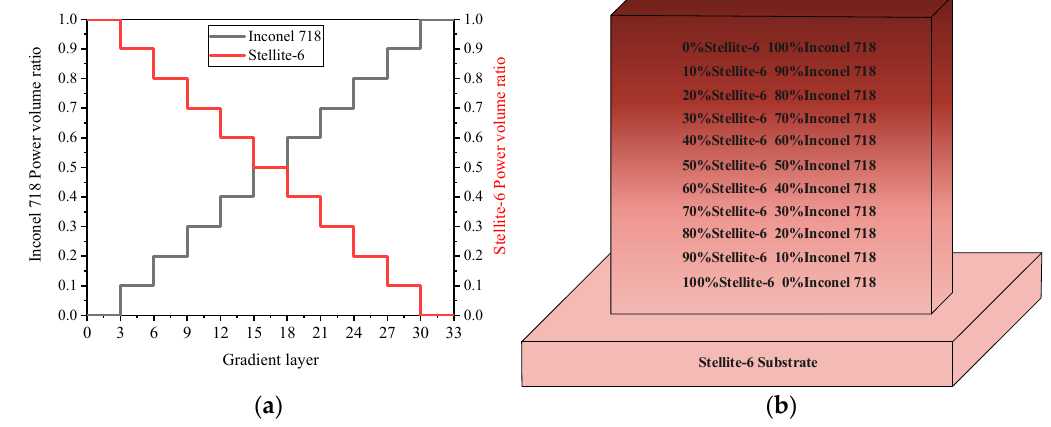
Figure 3. Stellite-6/Inconel 718 FGM: ( a ) powder volume ratio; ( b ) distribution of FGM layers.